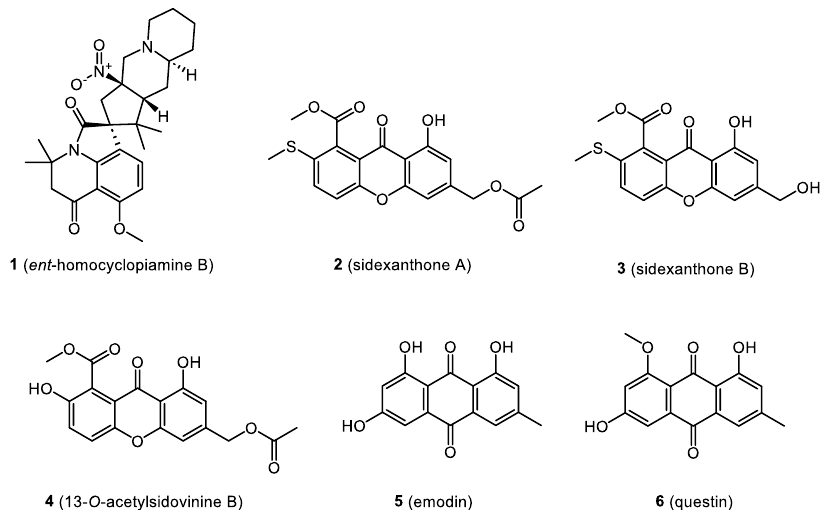
Figure 3. Bryendophyte metabolites with antimicrobial and immunosuppressive properties.